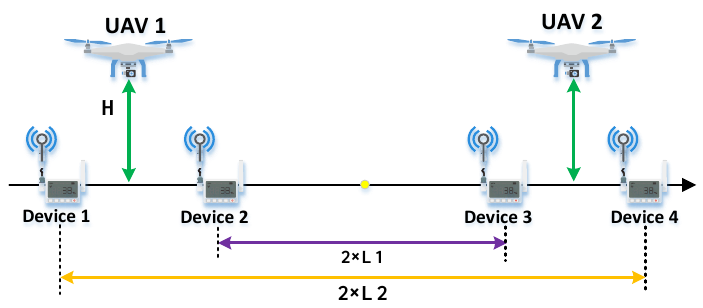
Figure 2. A basic network scenario with two UAVs and four devices, where the four devices are symmetrically distributed along a line and the two UAVs fly at a constant height to collect data from their served